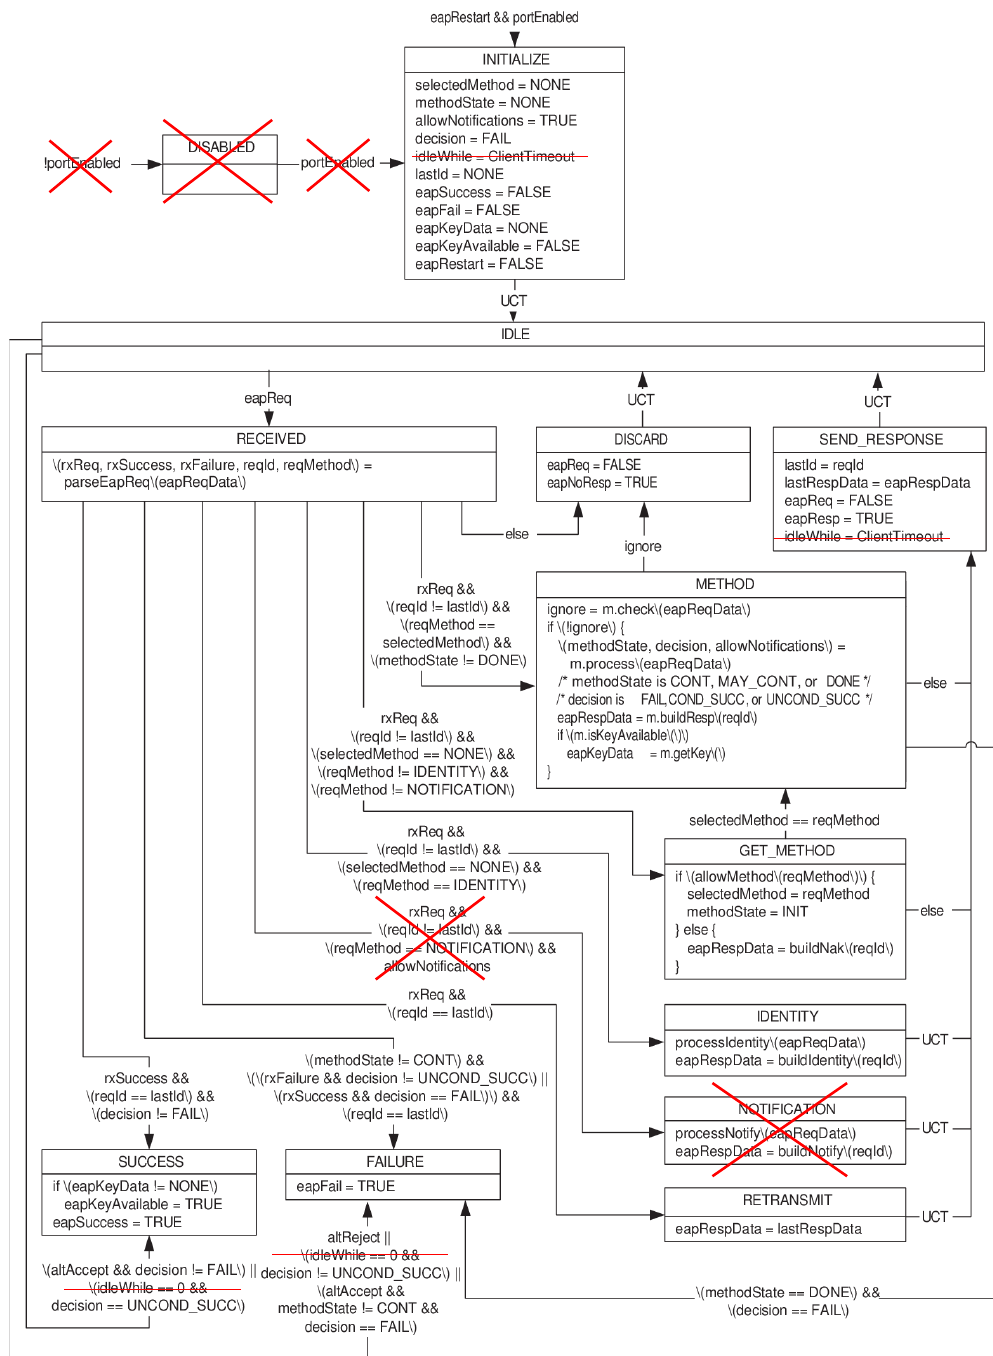
Figure B1. Light-weight EAP peer state